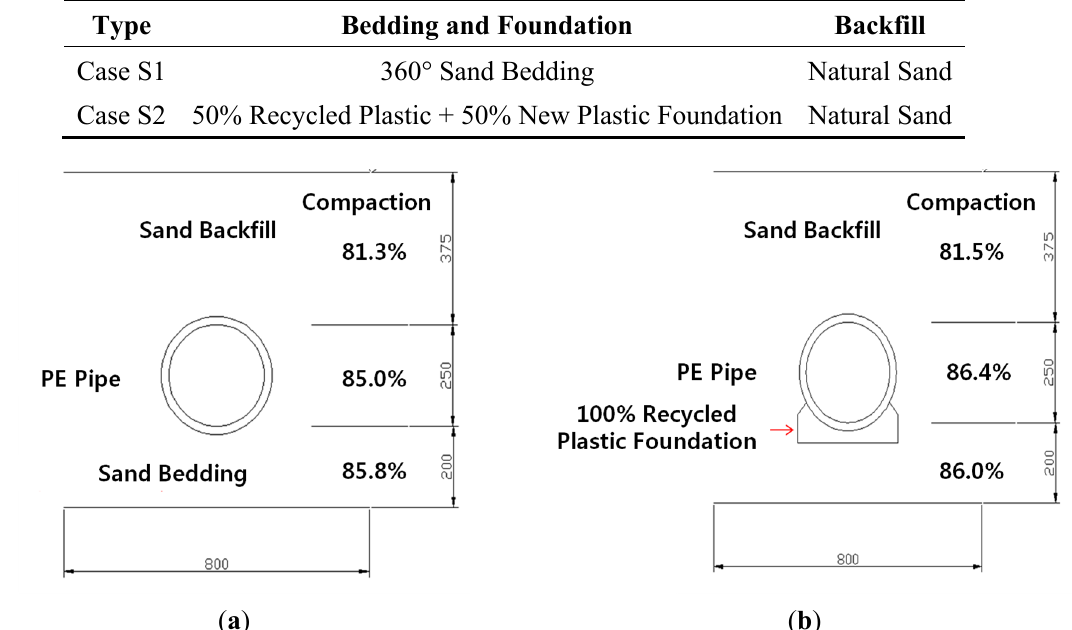
Figure 10. The two testing conditions, ( a ) Case S1; ( b ) Case S2.